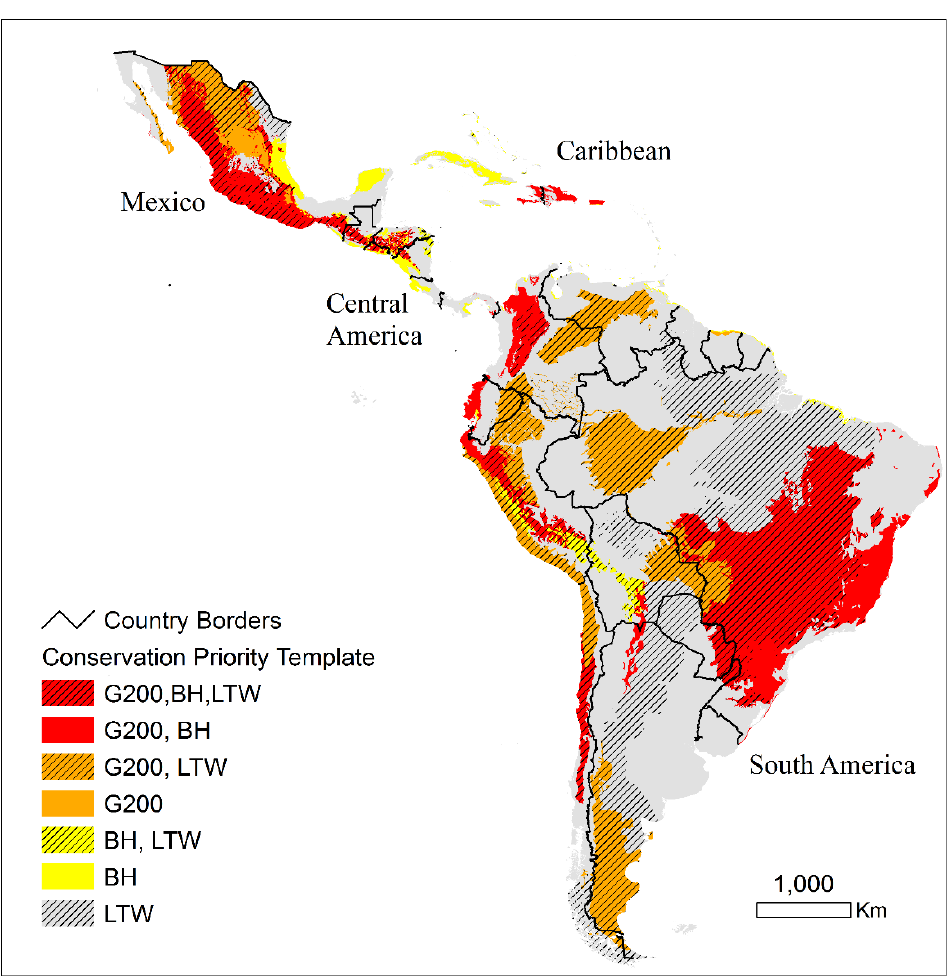
Figure 3. Conservation priorities as designated in the Global 200 (G200), Biodiversity Hotspot (BH) and Last of the Wild (LTW) templates [38–40].